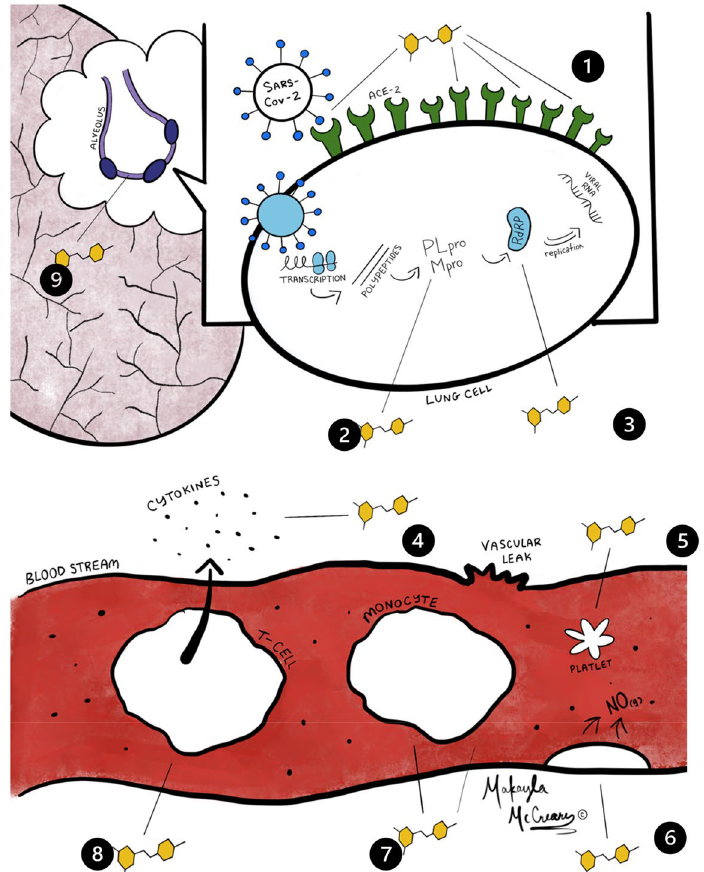
Figure 1. Summary of potential resveratrol effects on virus and host. 1. Inhibits Spike protein to ACE2 binding 4,5 . 2. Inhibits transcription of viral proteases (Mpro and PLpro) 6–9 . 3. Inhibits RNA-dependent RNA polymerase 10 . 4. Inhibits proinflammatory cytokines 11–13 . 5. Inhibits platelet aggregation 14,15 . 6. Activates endothelial Nitric Oxide (antiviral and vasoprotective) 16–18 . 7. Inhibits proinflammatory NF-kB 19 . 8.